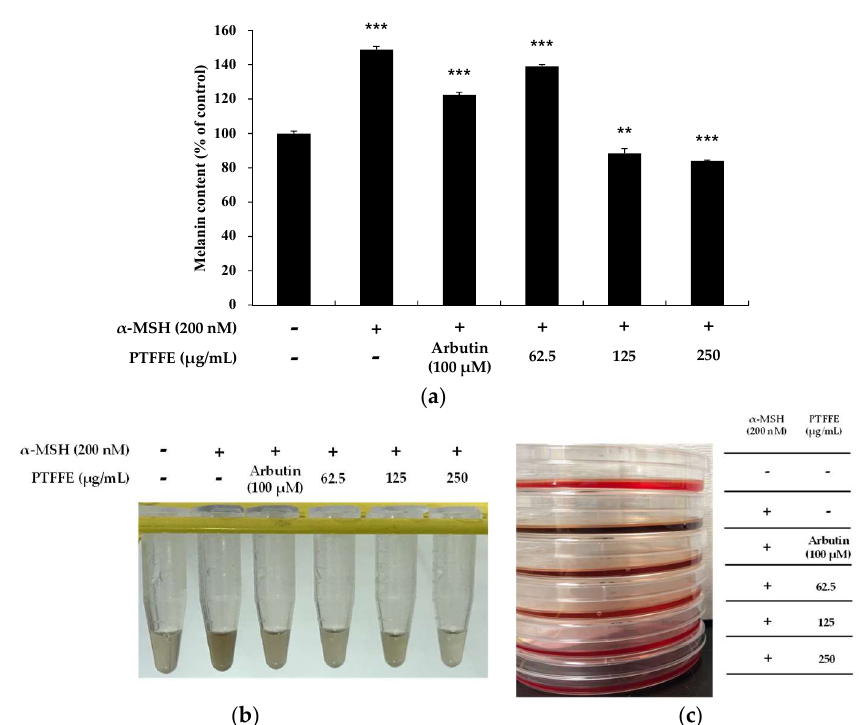
Figure 2. Effects of PTFFE on melanin production in B16F10 melanoma cells. Cells were treated with PTFFE at the indicated concentrations for 72 h. α-MSH (200 nM) and arbutin (100 μM) were used as a stimulator and a positive control, respectively. The melanin content is expressed as a percentage relative to the value in the untreated cells. The data are presented as the mean ± SD of at least three independent experiments ( a ). ** p < 0.01, *** p < 0.001. The dissolution of the cell pellet and the photograph of the culture medium were shown in ( b , c ), respectively.